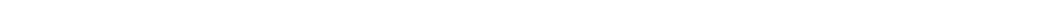
(x-axis)(See figure on next Fig. 4 Bioinformatic analysis of RCAN1 in various cancers based on TCGA database. A The expression profile of RCAN1 in various cancers. B Associations between RCAN1 expression and overall survival across human cancers (x-axis). C Associations between RCAN1 expression and grade across human cancers (x-axis). D Associations between RCAN1 expression and stage across human cancers (x-axis). E Associations between RCAN1 expression and receptors across human cancers (x-axis). F Associations between RCAN1 expression and chemokines across human cancers (x-axis). G Associations between RCAN1 expression and immunoinhibitors across human cancers (x-axis). H Associations between RCAN1 expression and immunostimulators across human cancers (x-axis). I Associations between RCAN1 expression and tumor infiltrating lymphocytes (TILs) across human cancers